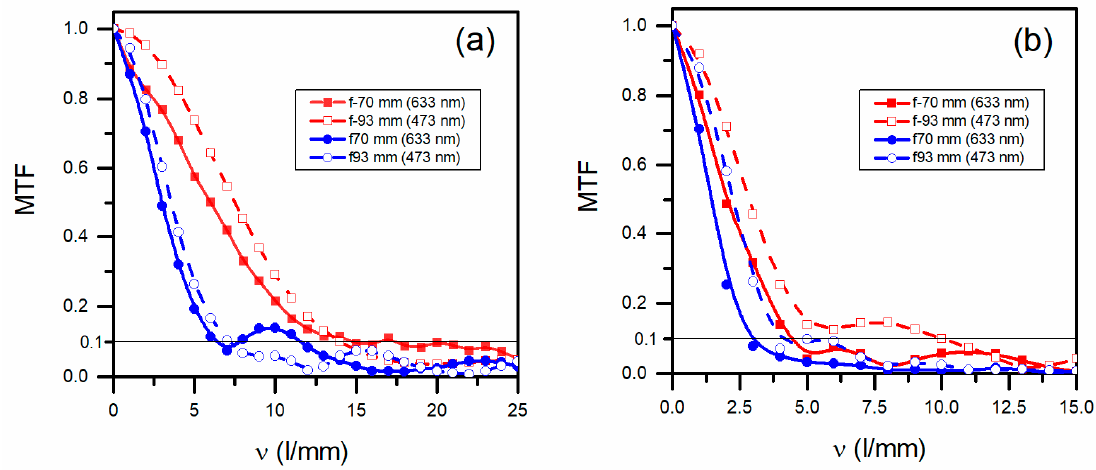
Figure 4. Experimental modulation transfer function (MTFs) for positive and negative HLs recorded ( a ) asymmetrically and ( b ) symmetrically. The frequencies of the HLs were determined for an MTF value of 0.1 (black, horizontal line).